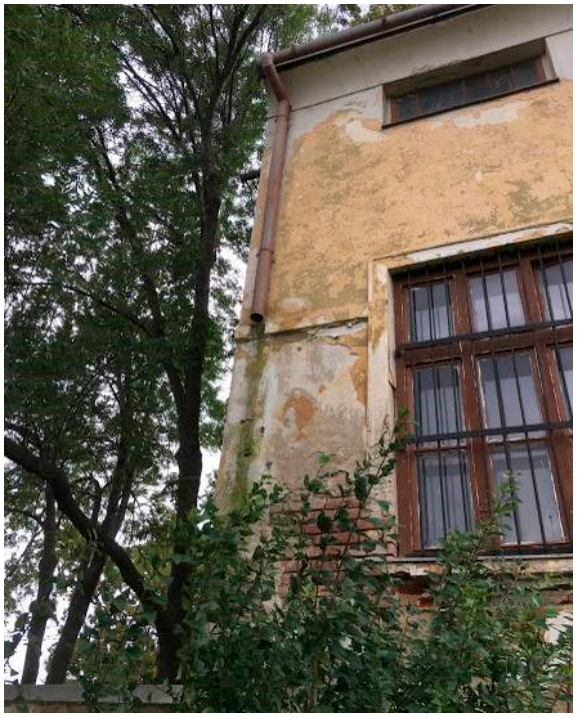
Figure 3. Facade condition before applying remediation intervention.